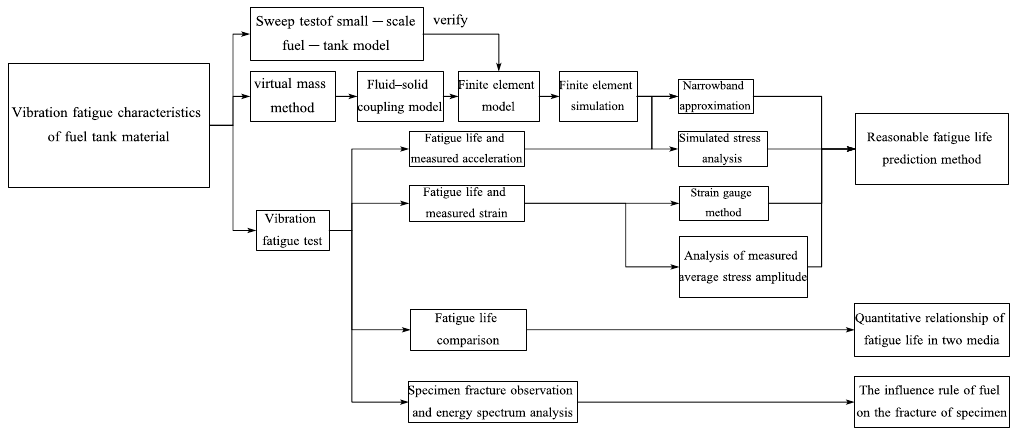
Figure 1. Flowchart of research method.